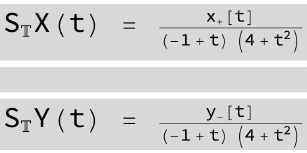
Figure 11. Output given by the [SInt] algorithm.